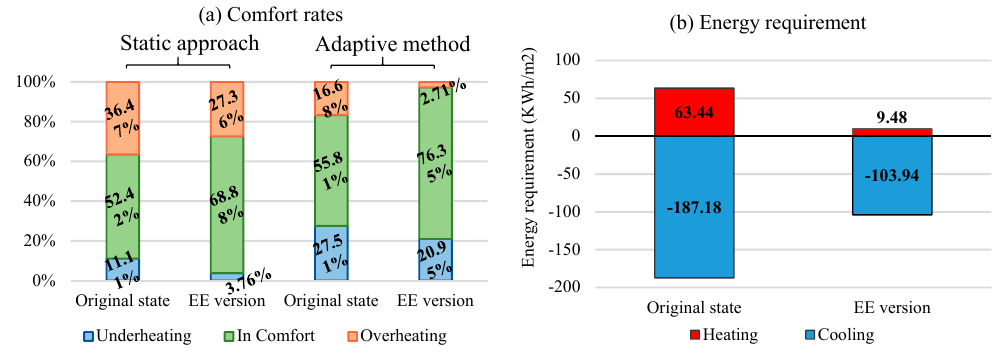
Figure 15. Results of the energy efficiency version of the building.